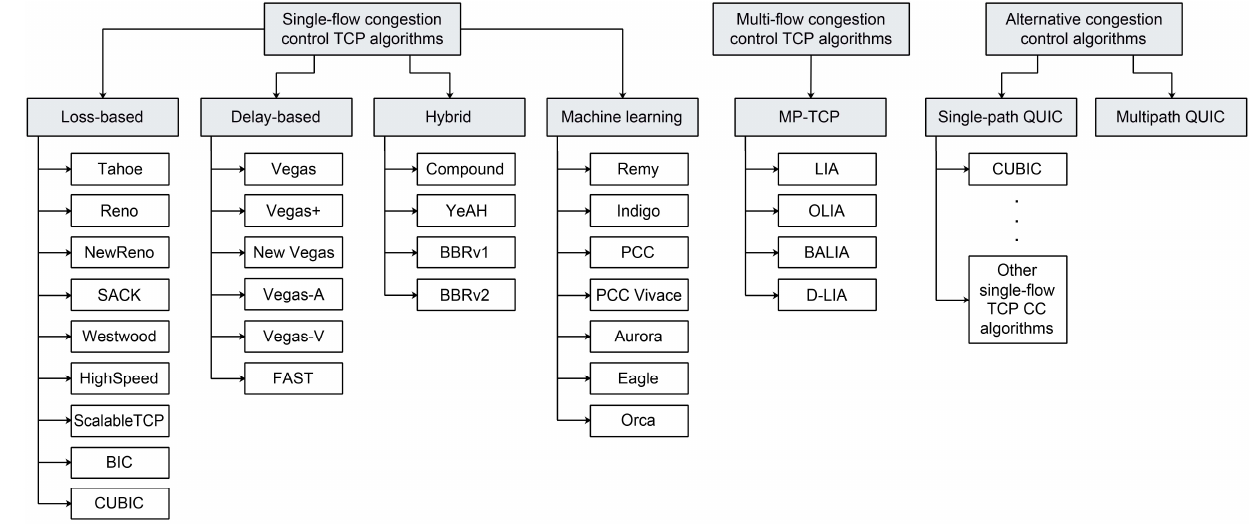
Figure 4. Main categories and types of the TCP CC algorithms.